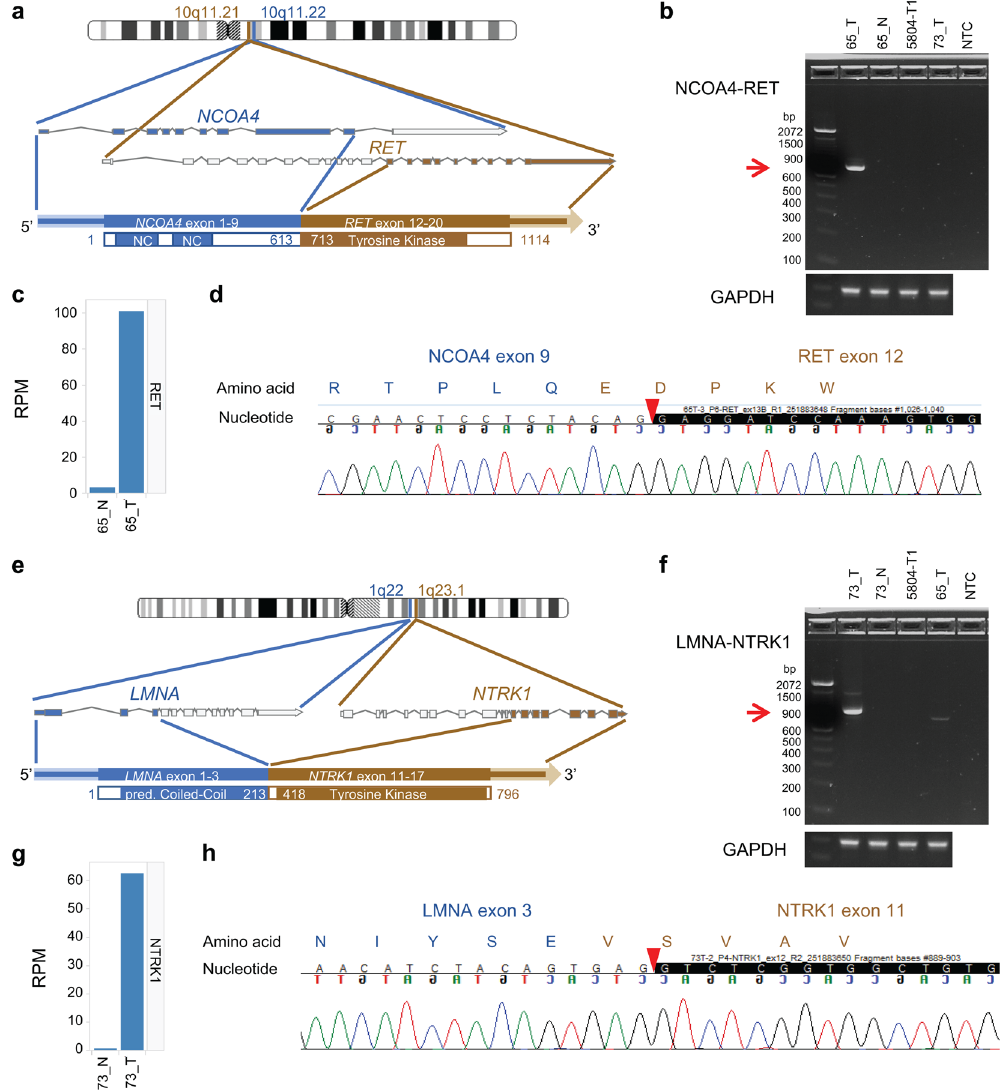
Figure 3. Characterization of NCOA4–RET and LMNA–NTRK1 gene fusions. ( a , e ) Schematic depiction of the gene fusion detected by RNA-Seq, indicating the genomic position, resulting fusion mRNA, and predicted protein consequences (with key protein domains indicated). ( b , f ) RT-PCR of RNA from the tumour or adjacent normal tissue with primers upstream and downstream of the gene fusion breakpoint. NTC, no template control. Red arrows indicate the size of the expected PCR product. ( c , g ) Overexpression of the 3 ′ fusion gene partner in the tumour relative to the adjacent normal tissue. RPM, reads per million. ( d , h ) Sanger sequencing of the RT-PCR product from ( b ) and ( f ). The red arrowheads indicate the position of the fusion junction and in-frame amino acid